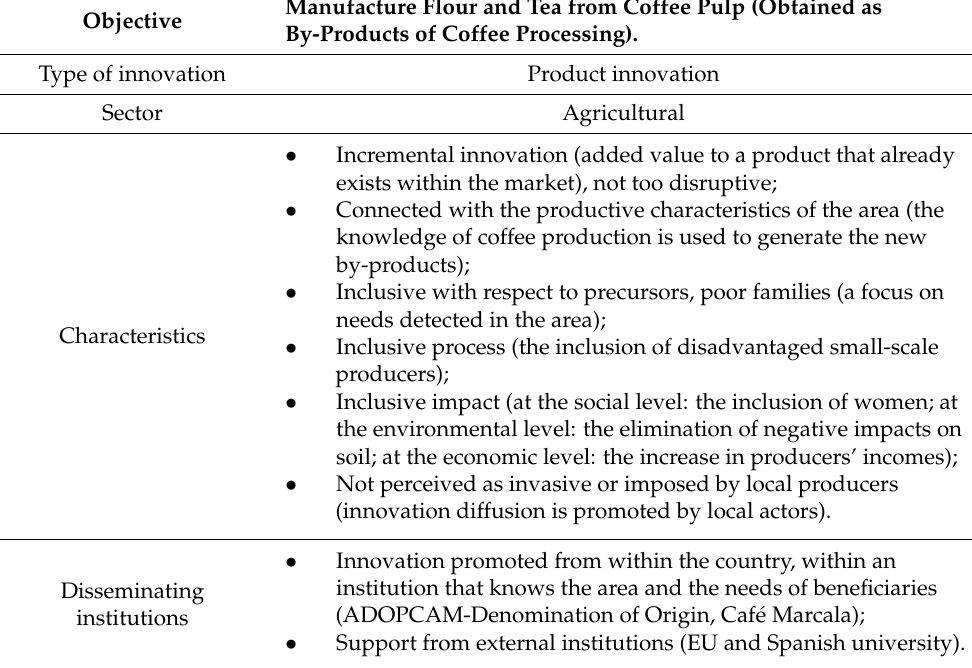
Table 1. Characteristics of the innovation under